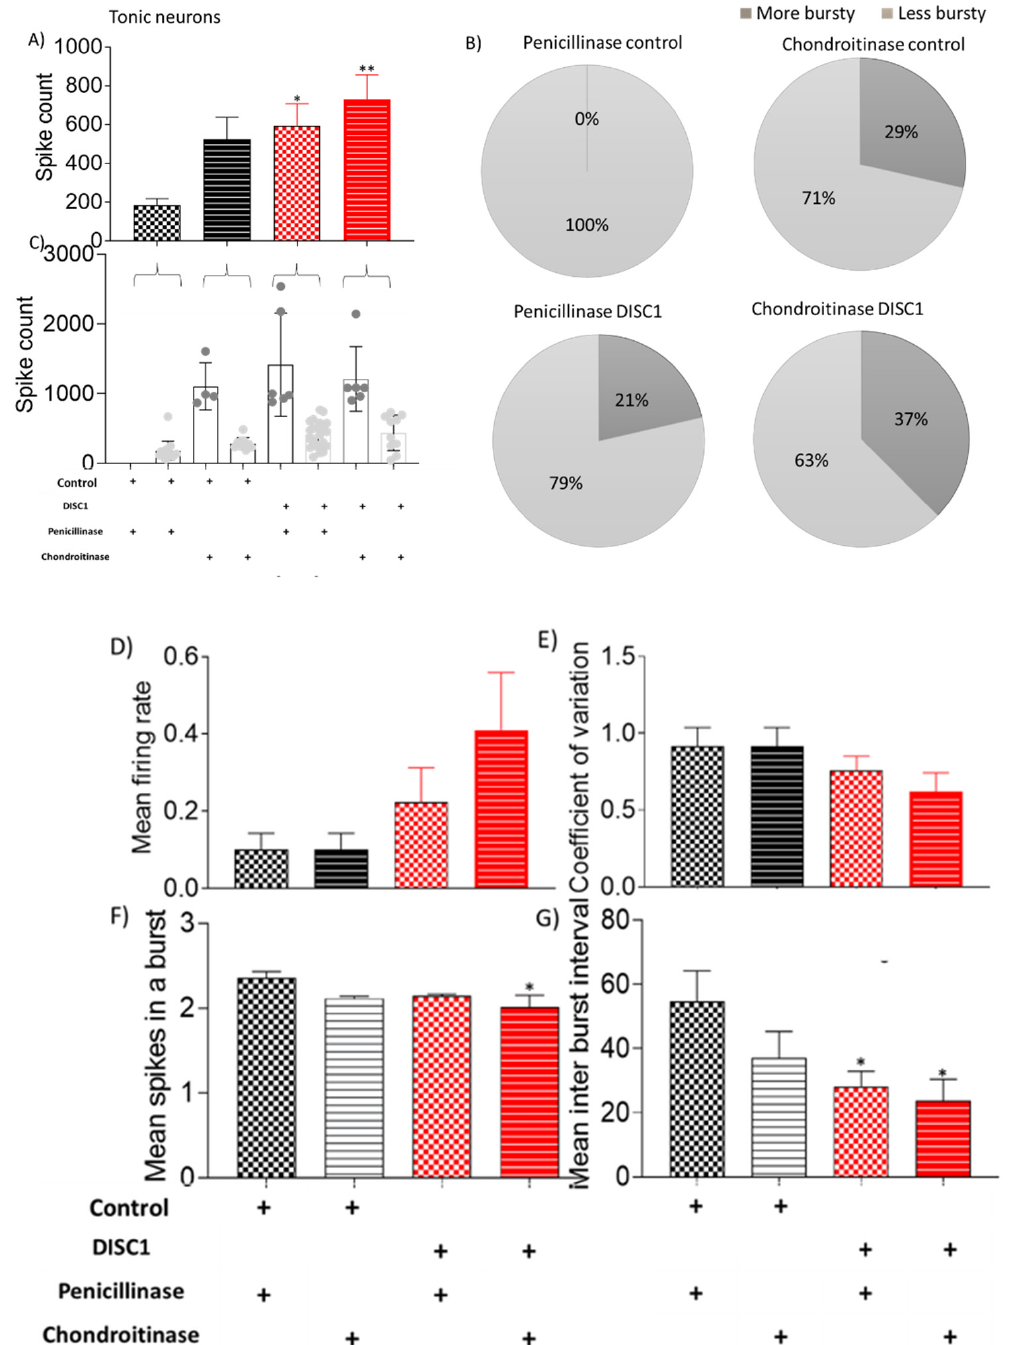
Figure 7. Characteristic of tonic neurons. ( A – C ) spike count in recorded potentials and pie chart representing distribution of high and low spike count over and below threshold from respective groups; ( D – G ) exhibiting mean firing rate, coefficient of variation, and mean spikes in a burst and mean inter-burst interval, respectively. The data are shown as mean ± s.e.m. where * p ≤ 0.05, ** p ≤ 0.01. * Represents comparison vs. penicillinase control.